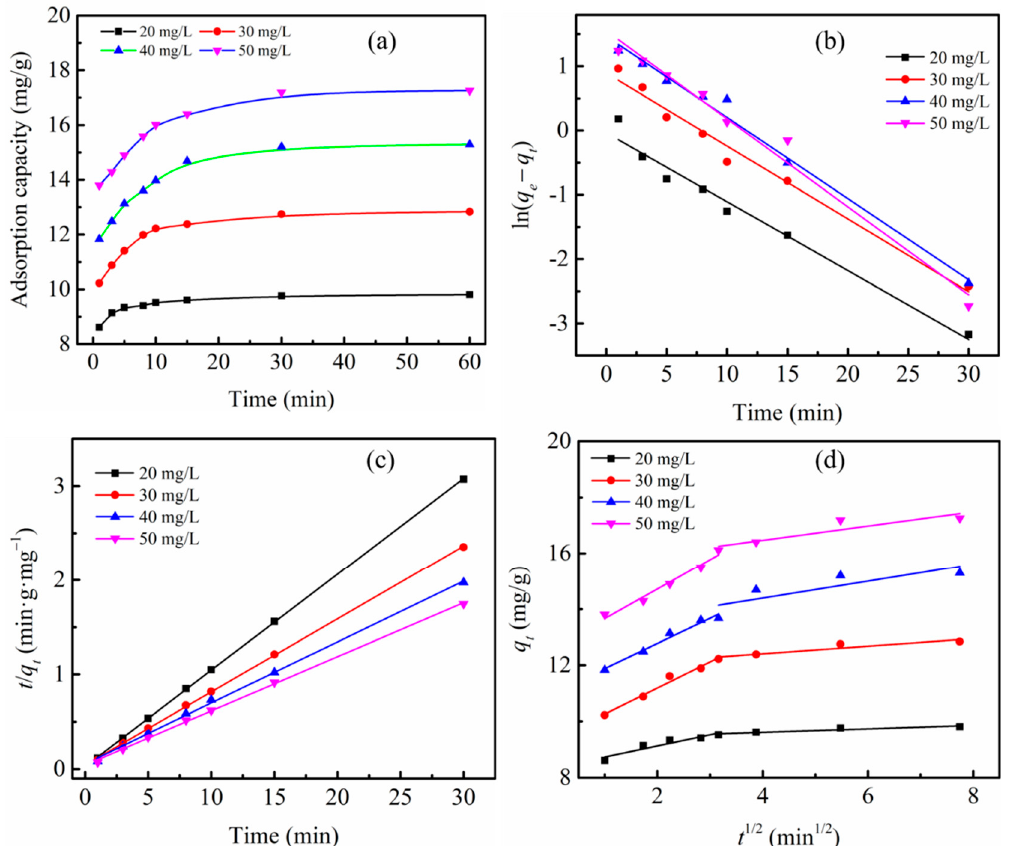
Figure 4. Adsorption kinetics of MB by the as-synthesized Fe 3 O 4 @C nanoparticles: ( a ) effect of adsorption time on adsorption capacity; ( b ) pseudo-first-order; ( c ) pseudo-second-order; ( d ) interparticle diffusion model. (T = 25 ◦ C, initial pH value = 6.0, adsorbent dosage: 2.0 g/L). Table 1. Kinetic parameters for adsorption of methyl blue on Fe 3 O 4 @C nanoparticles. q e(expe) C ini g · L − 1